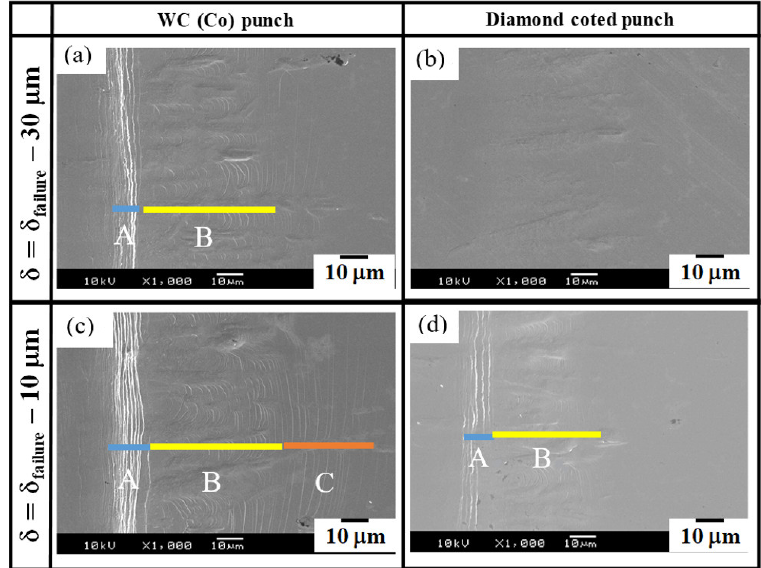
Figure 12. Variation of the 3rd electrical amorphous steel sheet in the stacked work by controlling the stroke δ during embossing with the use of two punches. δ failure denotes the critical stroke when the work is punched out. ( a ) Using WC(Co) punch and δ = δ failure − 30 µ m, ( b ) Using diamond coted punch and δ = δ failure − 30 µ m, ( c ) Using WC(Co) punch and δ = δ failure − 10 µ m, ( d ) Using diamond coted punch and δ = δ failure − 10 µ